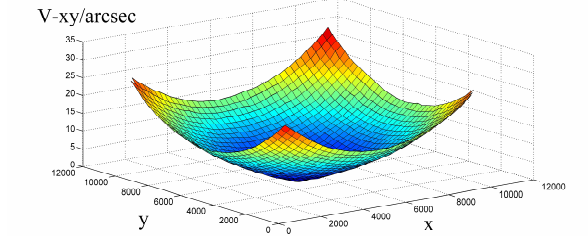
Figure. 3 Internal distortion surface of panchromatic sensor Table 4. Accuracy of the calibration of panchromatic sensor